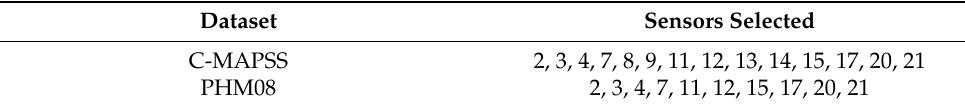
Table 2. Selection of